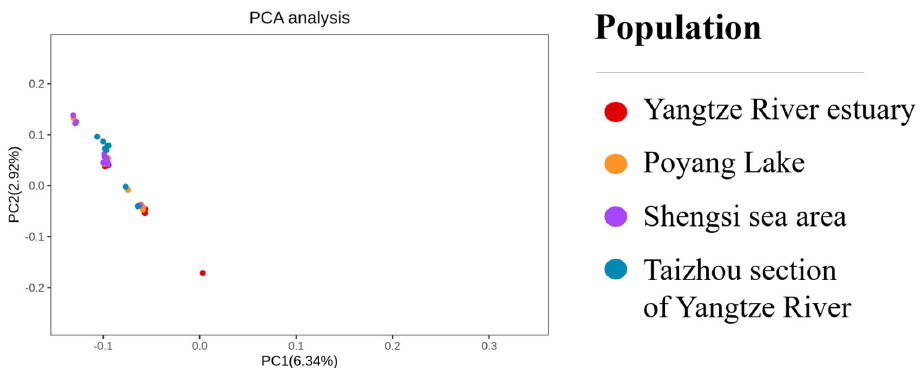
Figure 5. Principal component scatter plot.